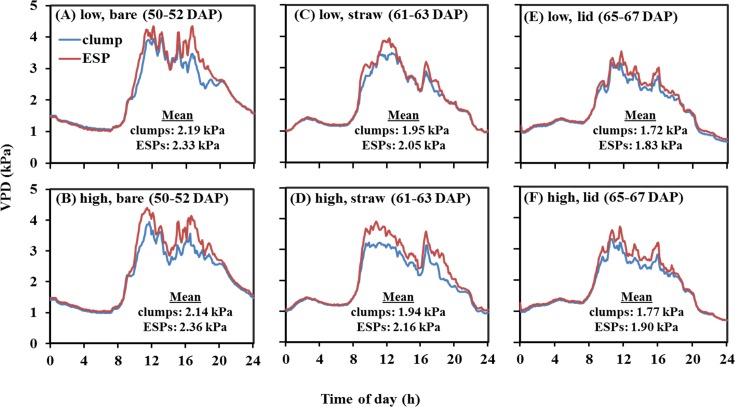
Average 3-day vapor pressure deficit (VPD) mean within the plant canopy recorded every five minutes for different treatments in 2013 at 50–52, 61–63, and 65–67 DAP corresponding to booting, flowering, and grain formation growth stages, respectively.DAP: days after planting; ESPs: evenly spaced plantings. The mean VPD is derived from the average of 2592 data points.